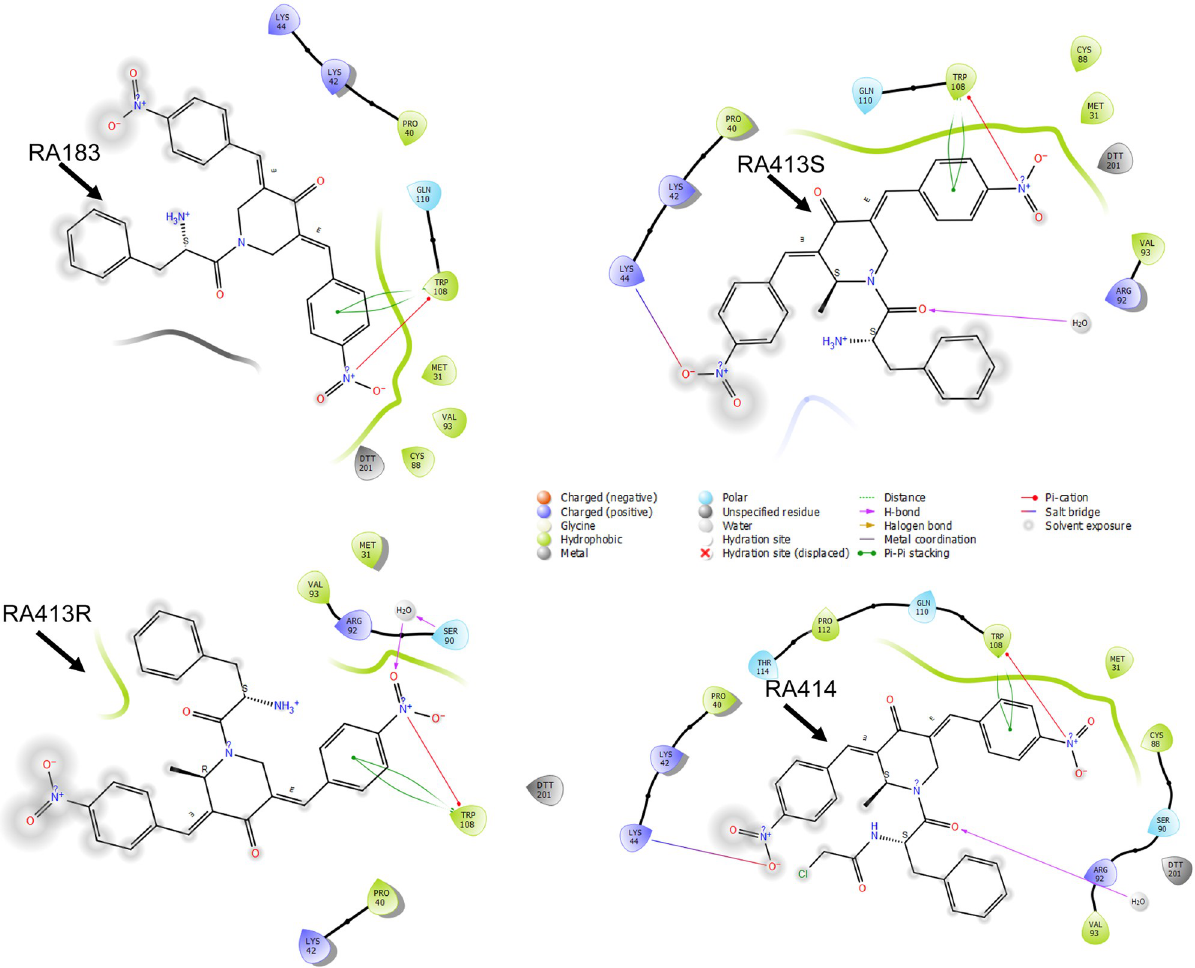
Fig 2. Molecular modeling of compounds binding to RPN13 Pru domain. (A-E) Docked complex of RA molecules (RA183, RA413S, RA413R and RA414) and RPN13 Pru Domain in the Schro¨dinger glide application.